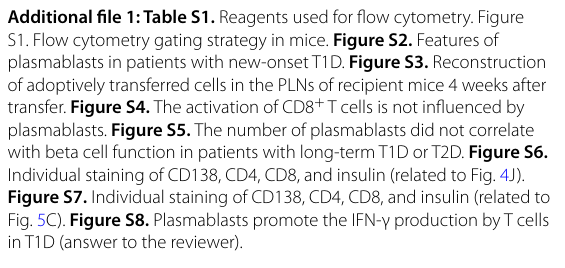
transfer. Figure S4. The activation of CD8 + T cells is not influenced by plasmablasts. Figure S5. The number of plasmablasts did not correlate with beta cell function in patients with long-term T1D or T2D. Figure S6. Individual staining of CD138, CD4, CD8, and insulin (related to Fig. 4J). Figure S7. Individual staining of CD138, CD4, CD8, and insulin (related to Fig. 5C). Figure S8. Plasmablasts promote the IFN-γ production by T cells in T1D (answer to the